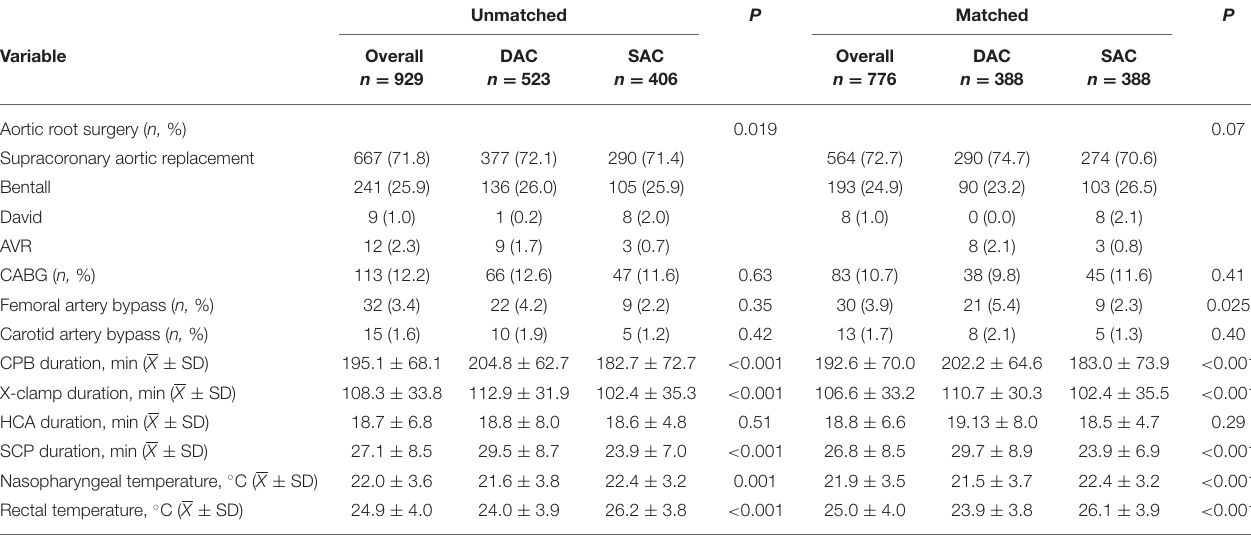
TABLE 2 | Operative characteristics.